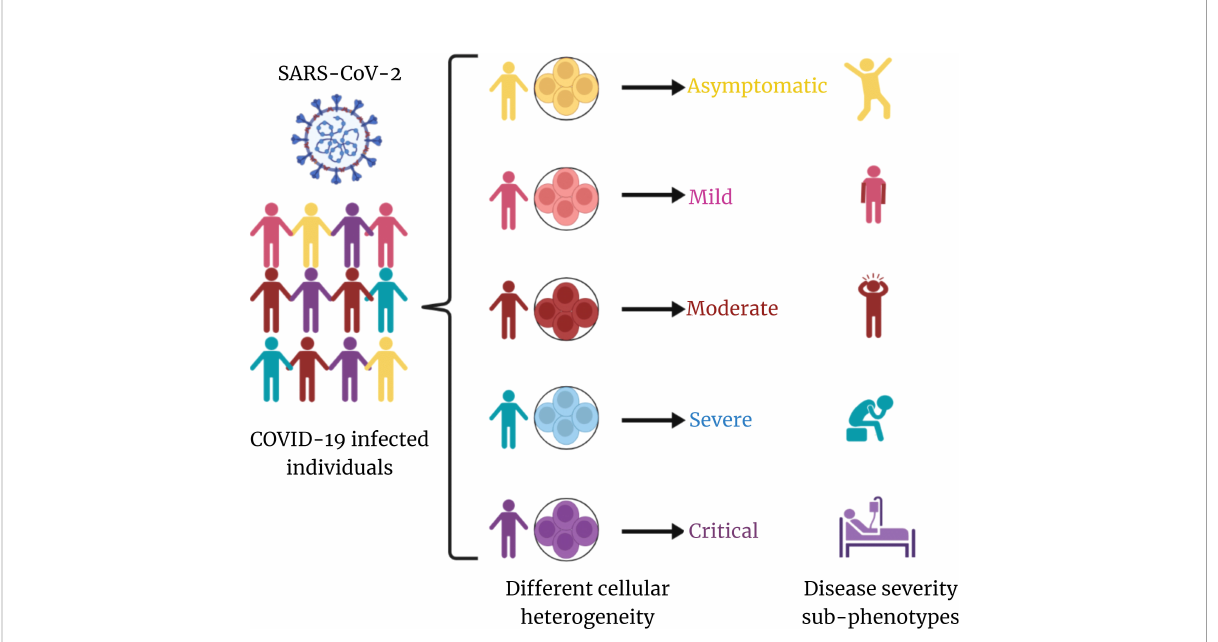
FIGURE 1 Overview of cellular heterogeneity across COVID-19 disease. SARS-CoV-2 – infected individuals exhibit distinct cellular heterogeneity, which is contributing toward the diversity in COVID-19 disease severity sub-phenotypes. This is at the core of differential clinical outcome of recovered and mortality albeit infected by same/similar clade/lineage of the